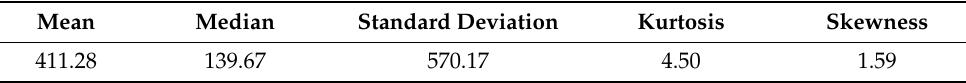
Table 4. Statistics of hourly produced power in